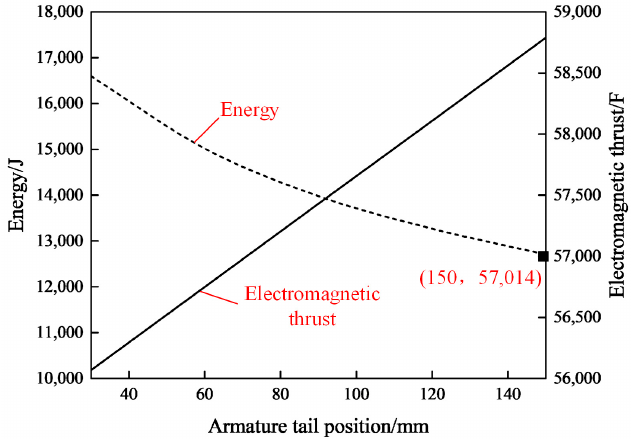
Figure 9. Simulation results of enhanced eddy current field.